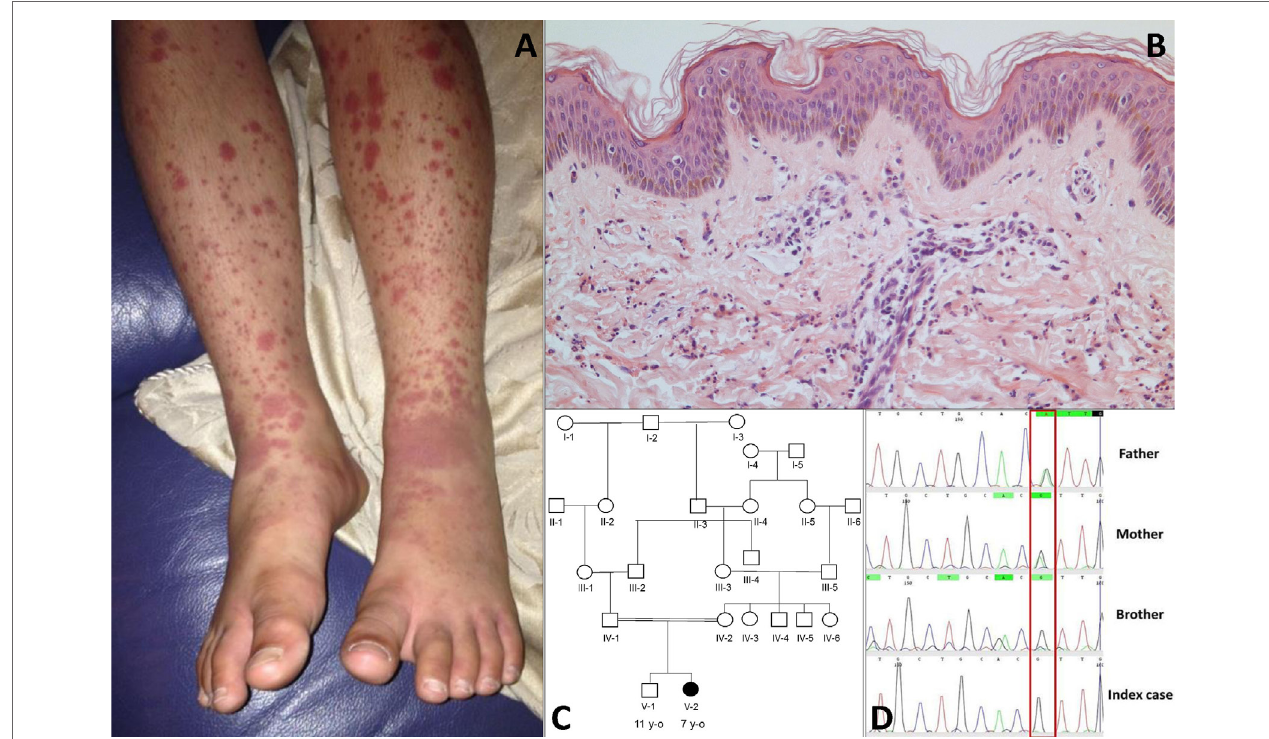
FIGURe 1 | (a) Cutaneous vasculitis over both lower extremities of the index case [V-2; (C) ]. (B) Skin biopsy of the lesion showing a dermal perivascular and interstitial infiltrate of predominantly neutrophils and nuclear dust which is compatible with leukocytoclastic vasculitis (haematoxylin & eosin stain, high magnification). (C) Family pedigree. (D) Sanger sequencing confirmed a homozygous G/G mutation (single black line) at position 1,139 of complement factor I gene in the index case and the asymptomatic brother; a heterozygous A/G state (Green/black line) was confirmed in both parents.